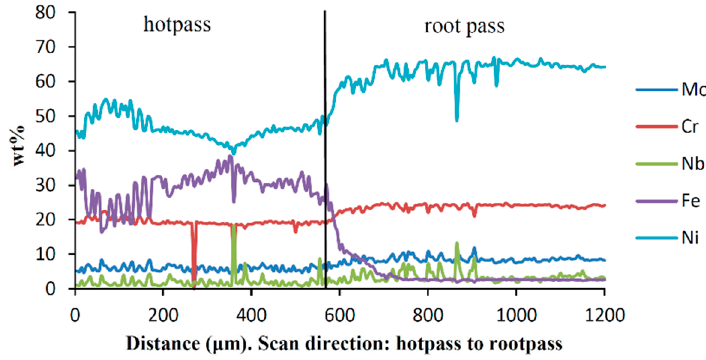
Figure 16. EPMA quantitative analysis of X60 steel pipe with Inconel 625 filler wire [19] .